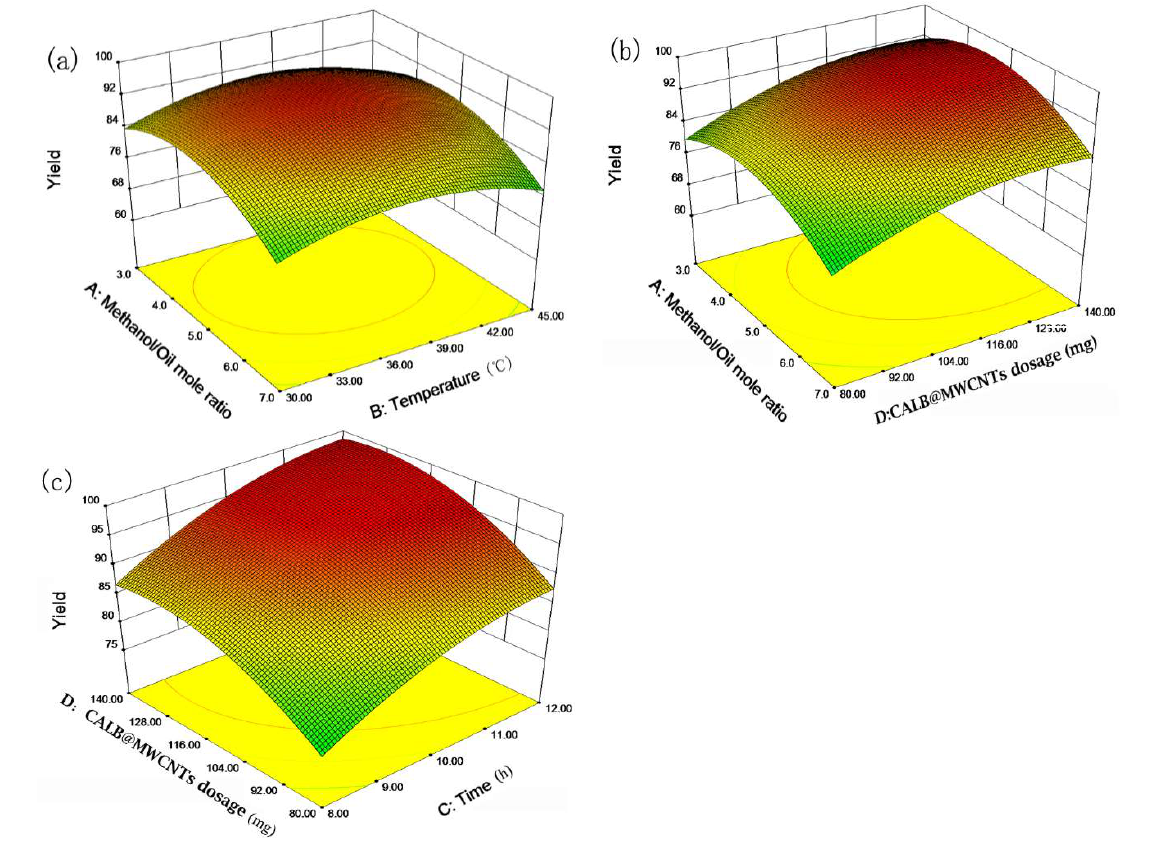
Figure 5. Response surface plots showing the effect of two parameters on the yield of biodiesel: ( a ) molar ratio of methanol to oil vs temperature; ( b ) molar ratio of methanol to oil vs CALB@PE dosage; ( c ) time vs CALB@PE dosage.